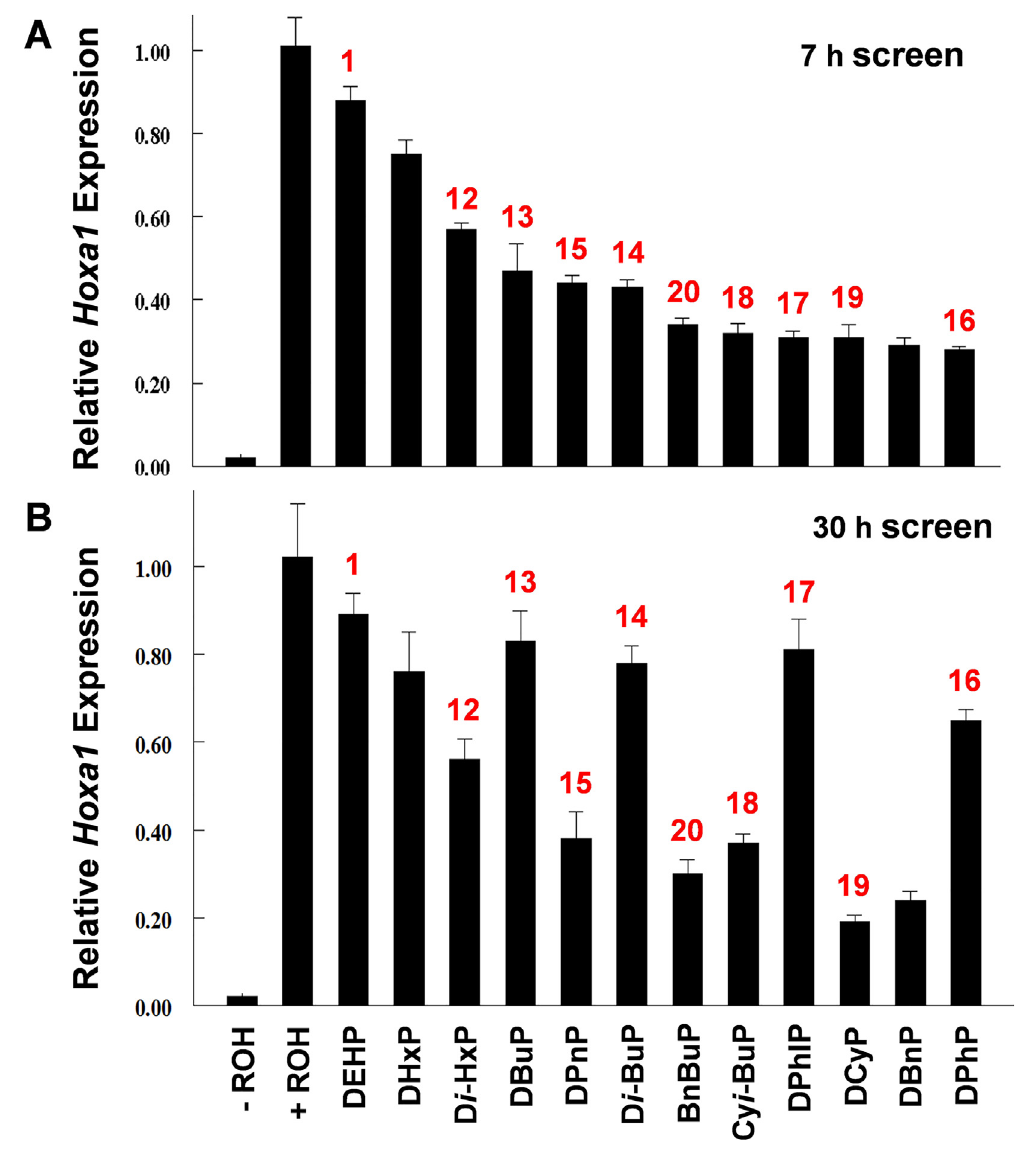
Fig 3. Comparison of short-term and long-term effects of PEs on the induction of Hoxa1 expression by ROH. The same compound numbering used in Fig 2 is used in Fig 3. Compounds are arranged in Fig 3A according to their relative inhibitory activity and that format is maintained for the 30 h assay (Fig 3B). The screens were carried out on PE #s 1, 12 – 20 (see Fig 2A) plus DHxP and DBnP which were not screened in Fig 2 and, therefore, are not numbered. (A) 7 h screen; (B) 30 h screen; n =